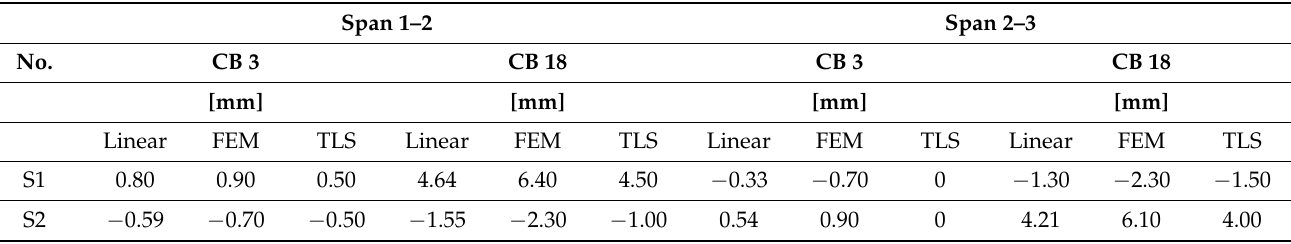
Table 1. Measurement results during